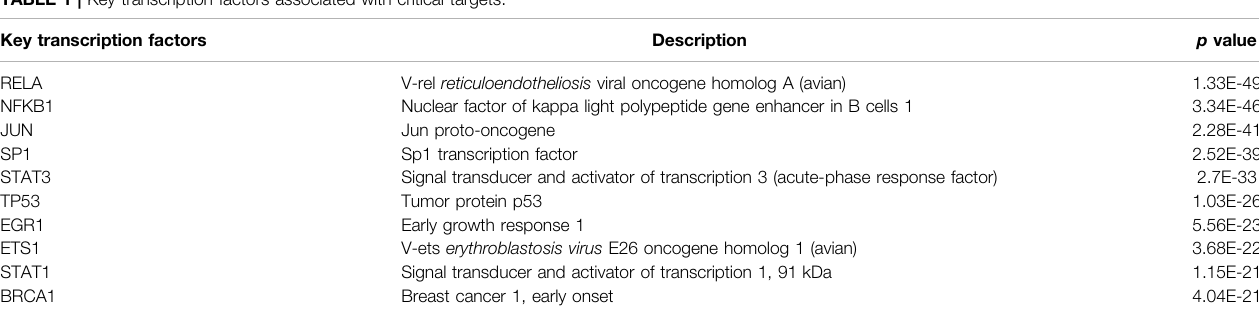
TABLE 1 | Key transcription factors associated with critical